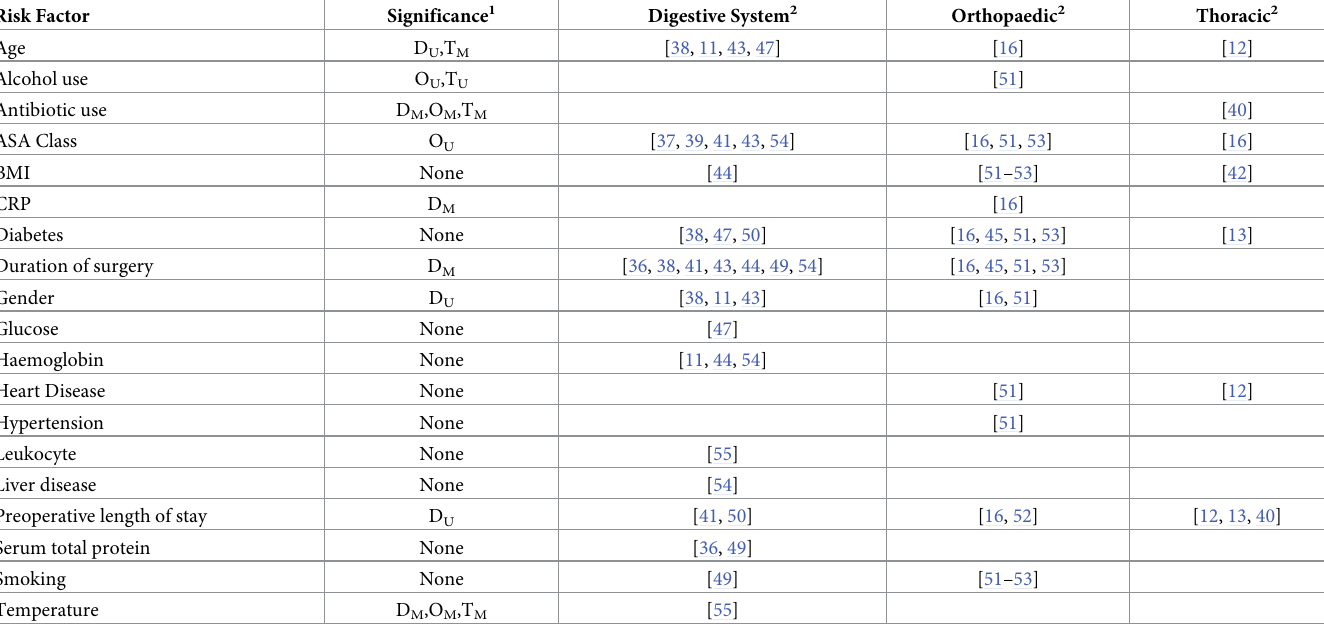
for thoracic surgeries. Antibiotic use and CRP were identified as risk factors for digestive sur- geries from the multivariate analysis, which were identified during the literature search for thoracic and orthopaedic surgeries, respectively. Antibiotic use and temperature were Table 5. Statistical significance of risk factors and the source which lead them to be considered by surgical